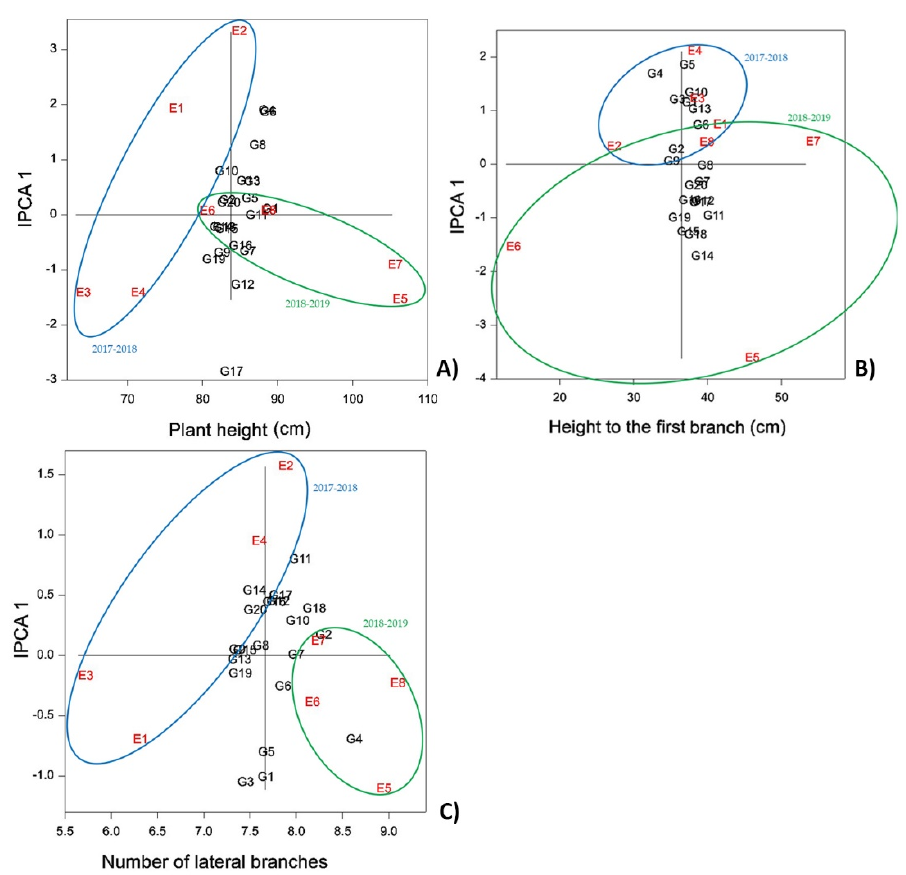
Figure 2. AMMI 1 biplots for ( A ) plant height (PH), ( B ) height to the first branch (HFB), and ( C ) number of lateral branches (NLB) of 20 camelina accessions across eight experimental environments. E = environment; G = genotype; blue frame—first growing year 2017–2018; green frame—second growing season 2018–2019.